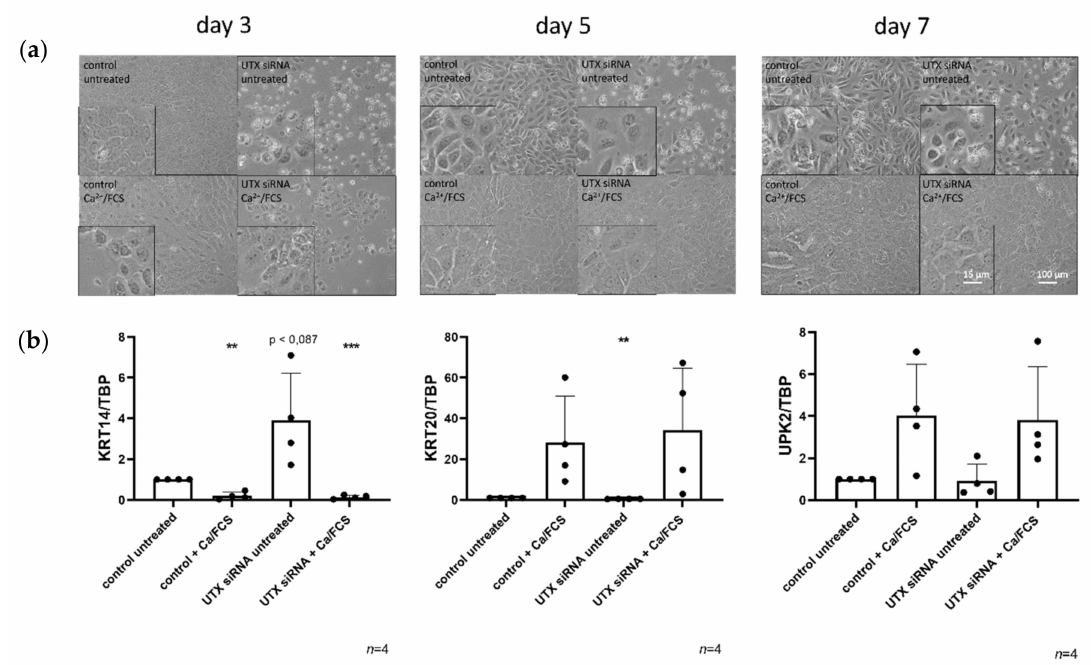
Figure 2. UTX-knockdown in HBLAK cells does not block di ff erentiation induced by Ca / FCS but reduces viability. ( a ) Morphology of HBLAK cells treated with control siRNA or UTX-siRNA 01 after 3, 5 and 7 days. A slight retardation of morphological di ff erentiation induced by Ca / FCS can be observed in UTX-siRNA treated cells compared to the control in the first five days. Note the changes in number and viability in cells not treated with Ca / FCS following UTX knockdown. ( b ) Expression of KRT14, KRT20 and UPK2 on day 10 after induction of di ff erentiation. Note the lack of significant di ff erences in the three markers in di ff erentiated cells, but the relative upregulation of KRT14 mRNA following UTX knockdown in cells not treated with Ca / FCS. Number of analyzed independent experiments, n = 4 or 5. Statistics were performed with a one sample t test against the set value of 1 for the untreated controls (** p < 0.01; *** p < 0.001). Scale 15 µ m or 100 µ